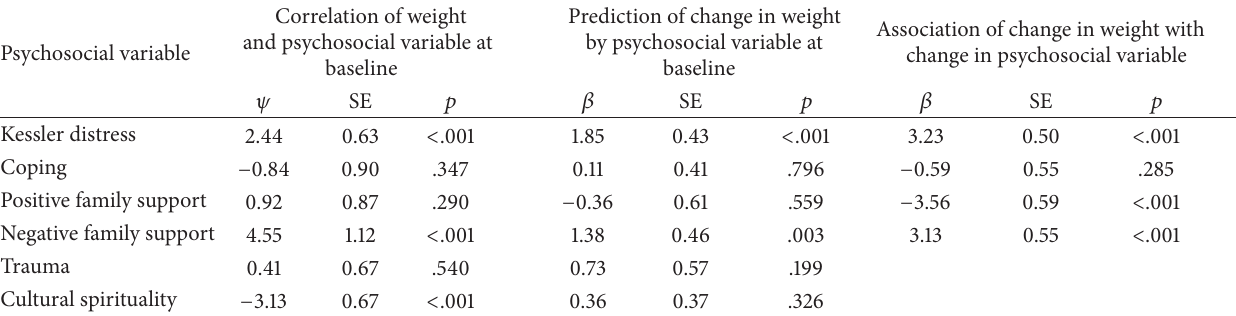
Table 3: Correlates of baseline weight ( 𝜓 ) and predictors of change in weight from baseline to follow-up ( 𝛽 ) (unstandardized bivariate model